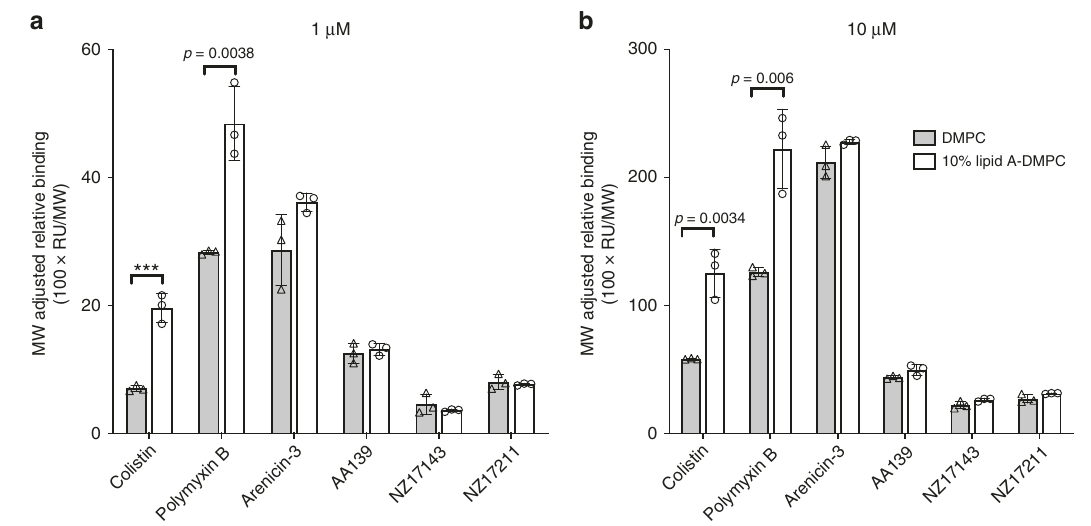
Fig. 2 Binding of arenicin-3 variants to lipids as monitored by SPR. Comparison of the propensity of arenicin-3, AA139, NZ17143, NZ17211, and other membrane binding antimicrobials, colistin and polymyxin B, to bind to various model membrane lipid systems. DMPC (gray) is compared to DMPC with 10% E. coli lipid A (white) at 1 µ M a and 10 µ M b . Mean data of n = 3 per test group is plotted with error bars shown as SEM. Signi fi cant difference in binding af fi nities can be seen for colistin and polymyxin B between the two lipid systems; however, not for arenicin-3 variants. Statistical comparison performed with Prism 8 using Student ’ s t -test, all differences between means with p < 0.01 are indicated; *** p ≤ 0.001. RU response unit, MW molecular weight. Source data are provided as a source data fi